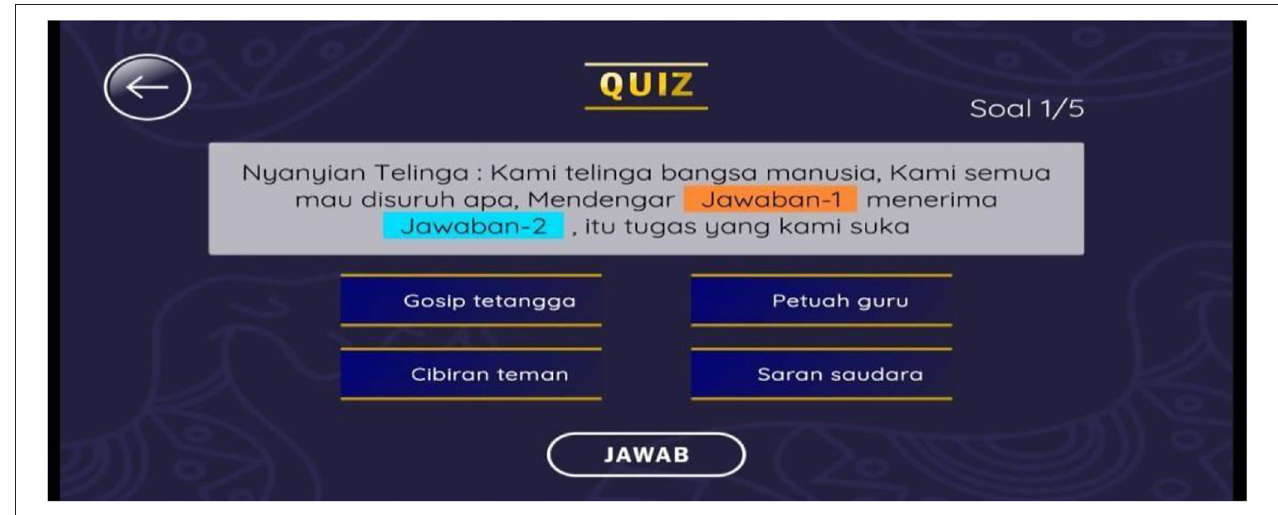
FIGURE 9 | Quiz feature in the Puppet Sukuraga